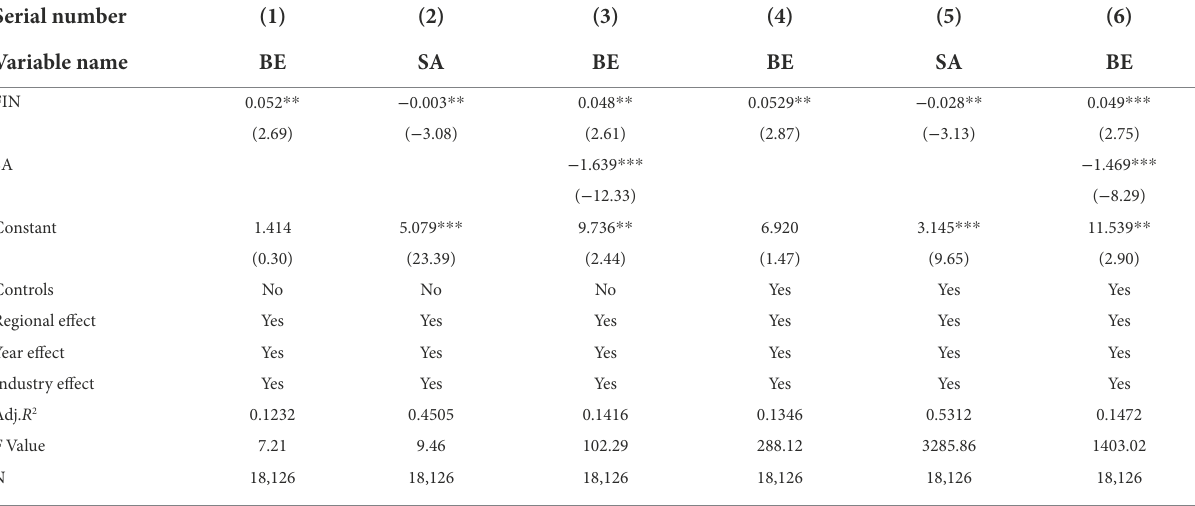
TABLE 4 Regression results of benchmark